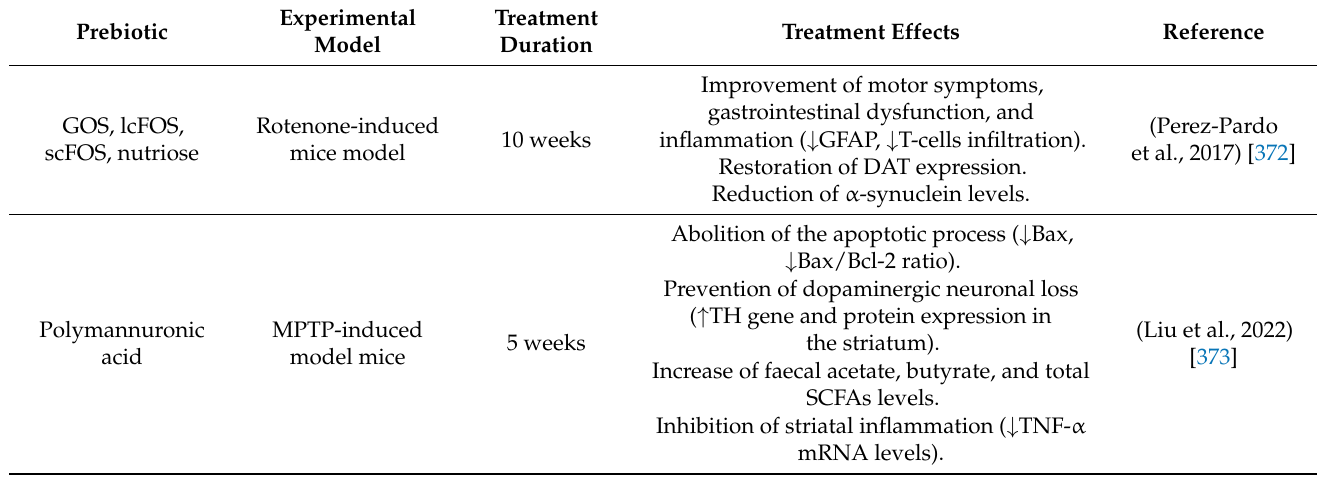
Table 2. The effects of prebiotics treatment regarding in vivo experimental